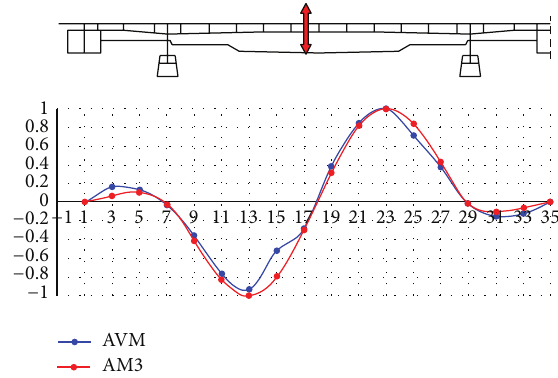
Figure 25: Experimentally and mathematically identified first vertical mode shapes.